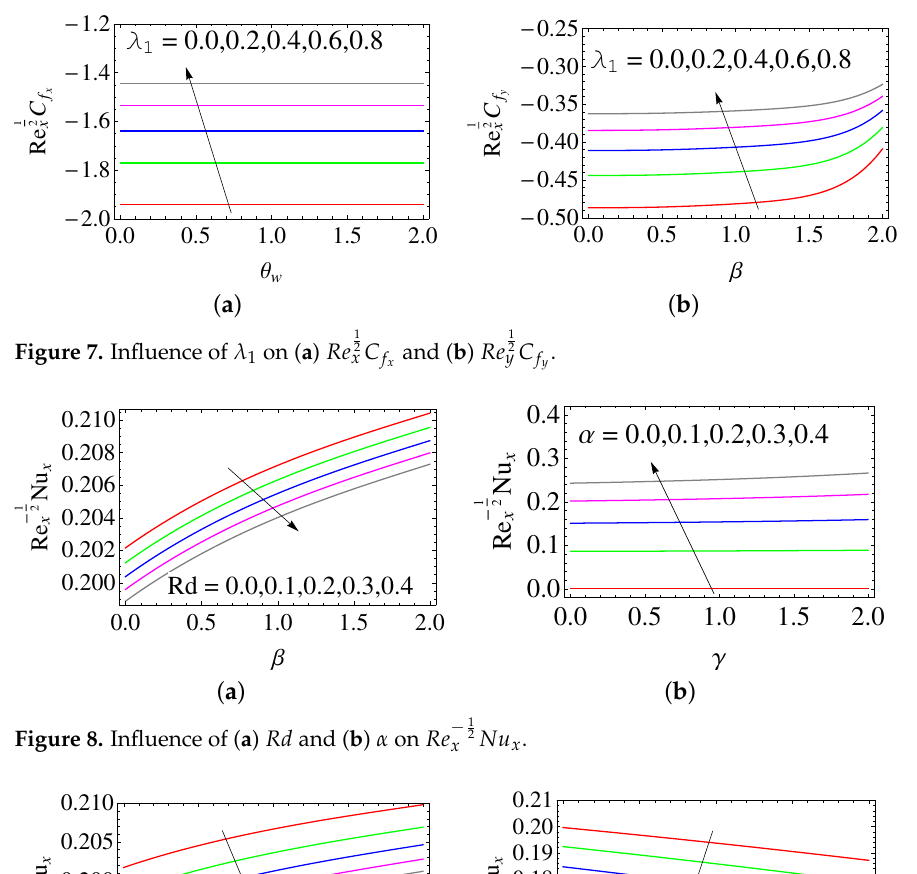
Figure 8. Influence of ( a ) Rd and ( b ) α on Re